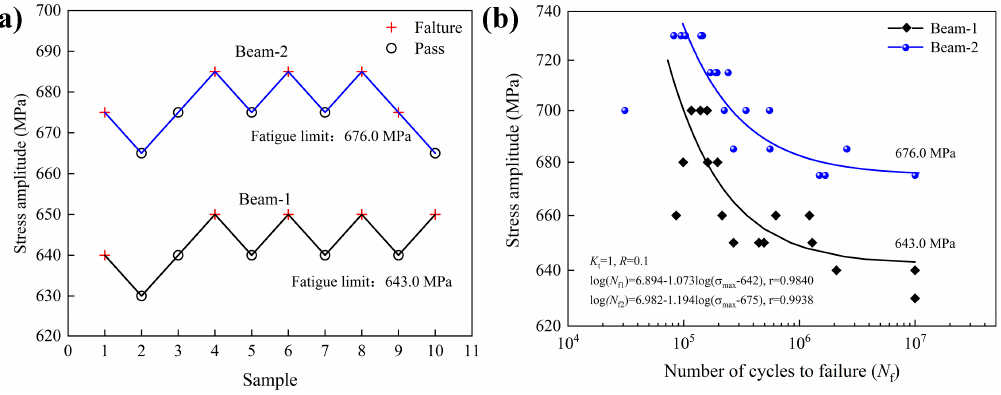
Figure 8. Fatigue strength results obtained by staircase method ( a ) and S-N curves ( b